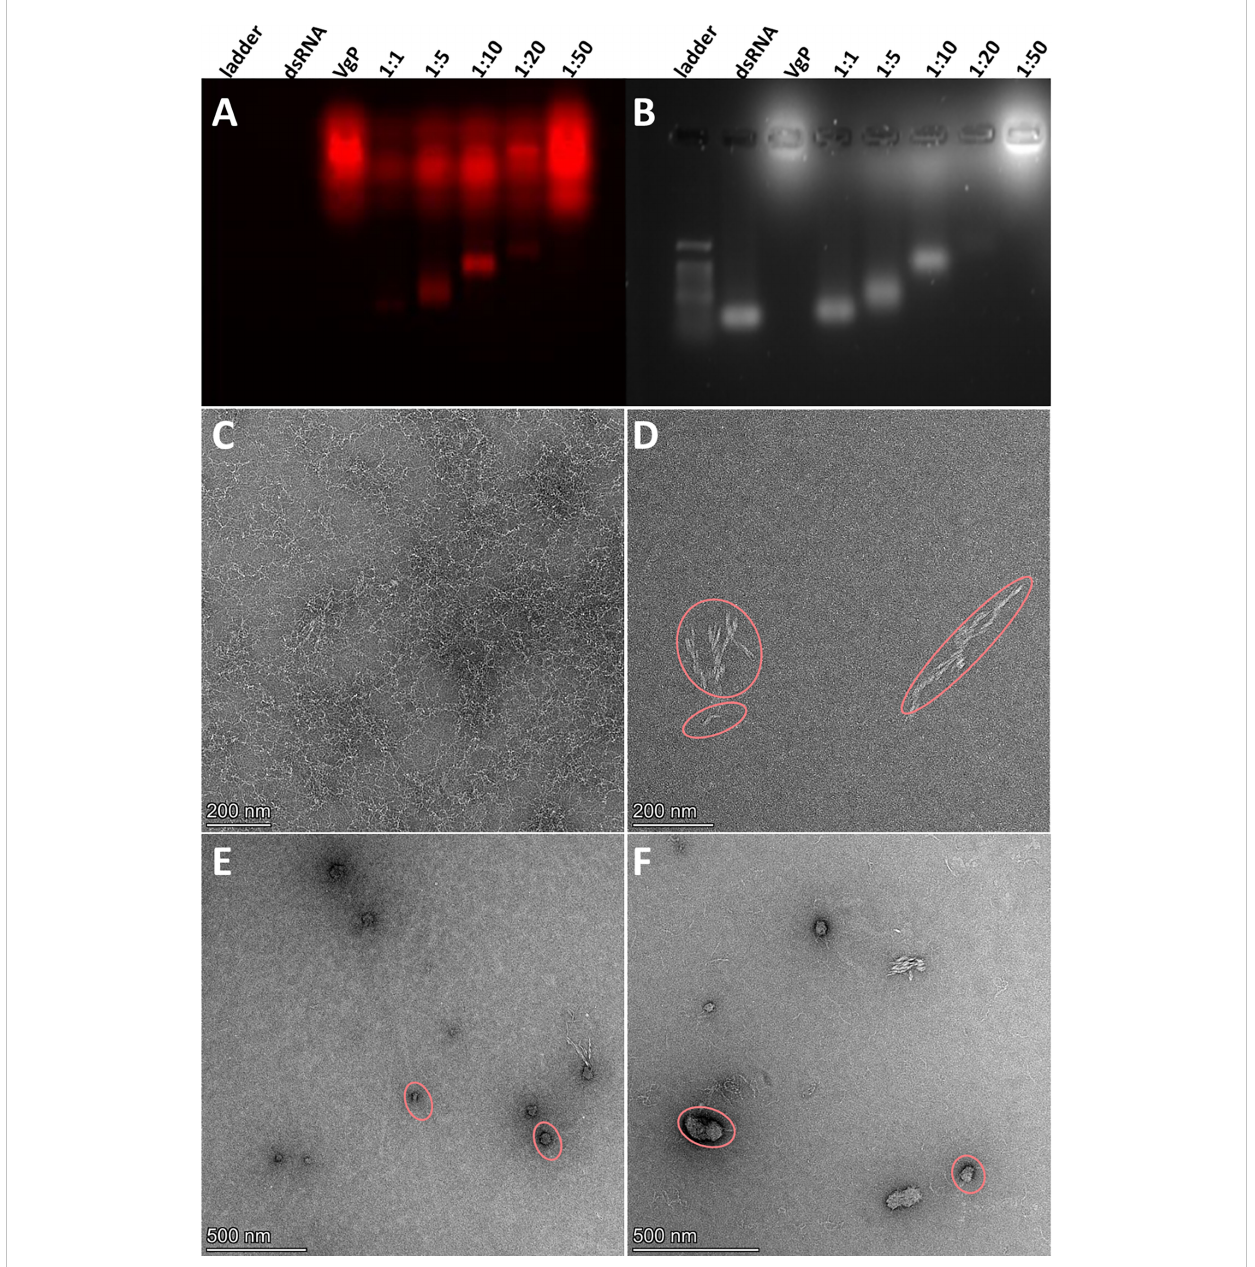
FIGURE 4 VgP-dsRNA complex validation and characterization. (A) Fluorescence emission (564 nm) image and (B) UV image of an agarose gel loaded with